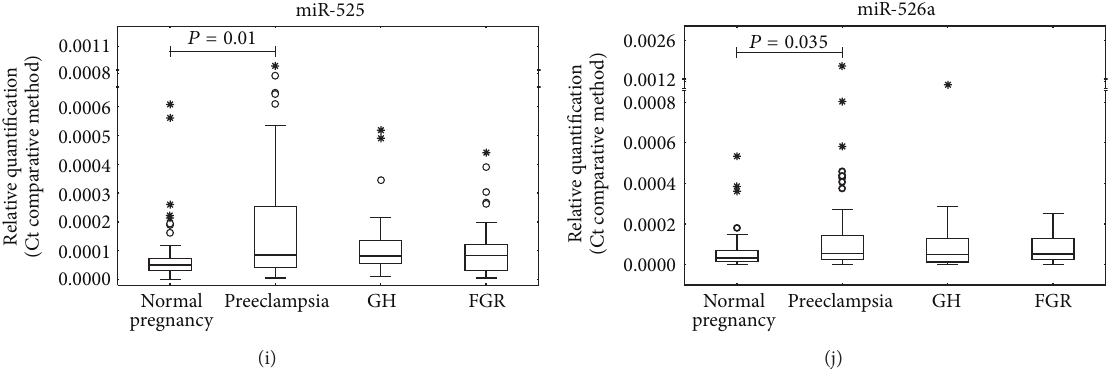
Figure 1: Upregulation of circulating C19MC microRNAs in pregnancies with preeclampsia. Absolute ((a), (b), (c), (d), and (e)) and relative ((f), (g), (h), (i), and (j)) quantification data were expressed as box plots of individual microRNAs in cohorts of normal and complicated pregnancies using Statistica software. The upper and lower limits of the boxes represent the 75th and 25th percentiles, respectively. The upper and lower whiskers represent the maximum and minimum values that are no more than 1.5 times the span of the interquartile range (range of the values between the 25th and the 75th percentiles). The median is indicated by the line in each box. Outliers are indicated by circles and extremes by